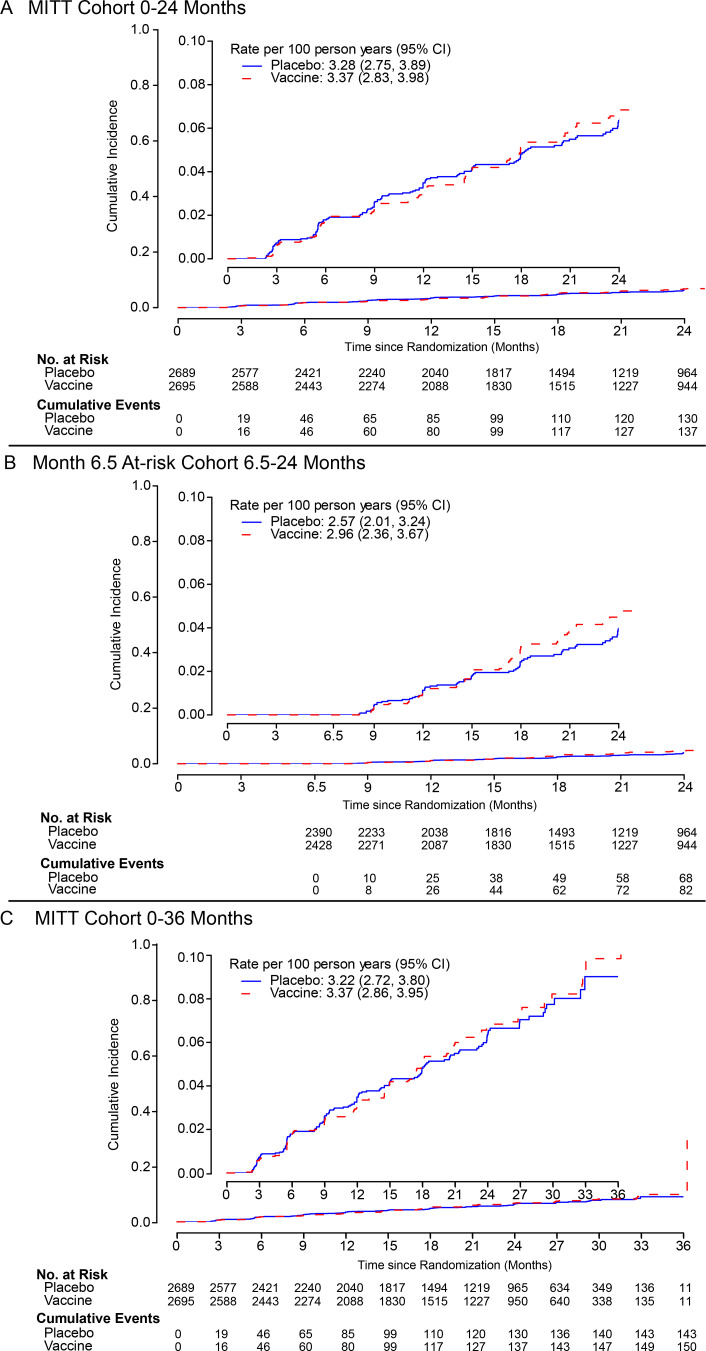
Cumulative incidence of HIV-1 infection. A. MITT cohort,
0-24 months. B. Month 6.5 at-risk cohort, 6.5-24 months. C. MITT
cohort, 0-36 months. Inset shows the same data on an expanded
axis.